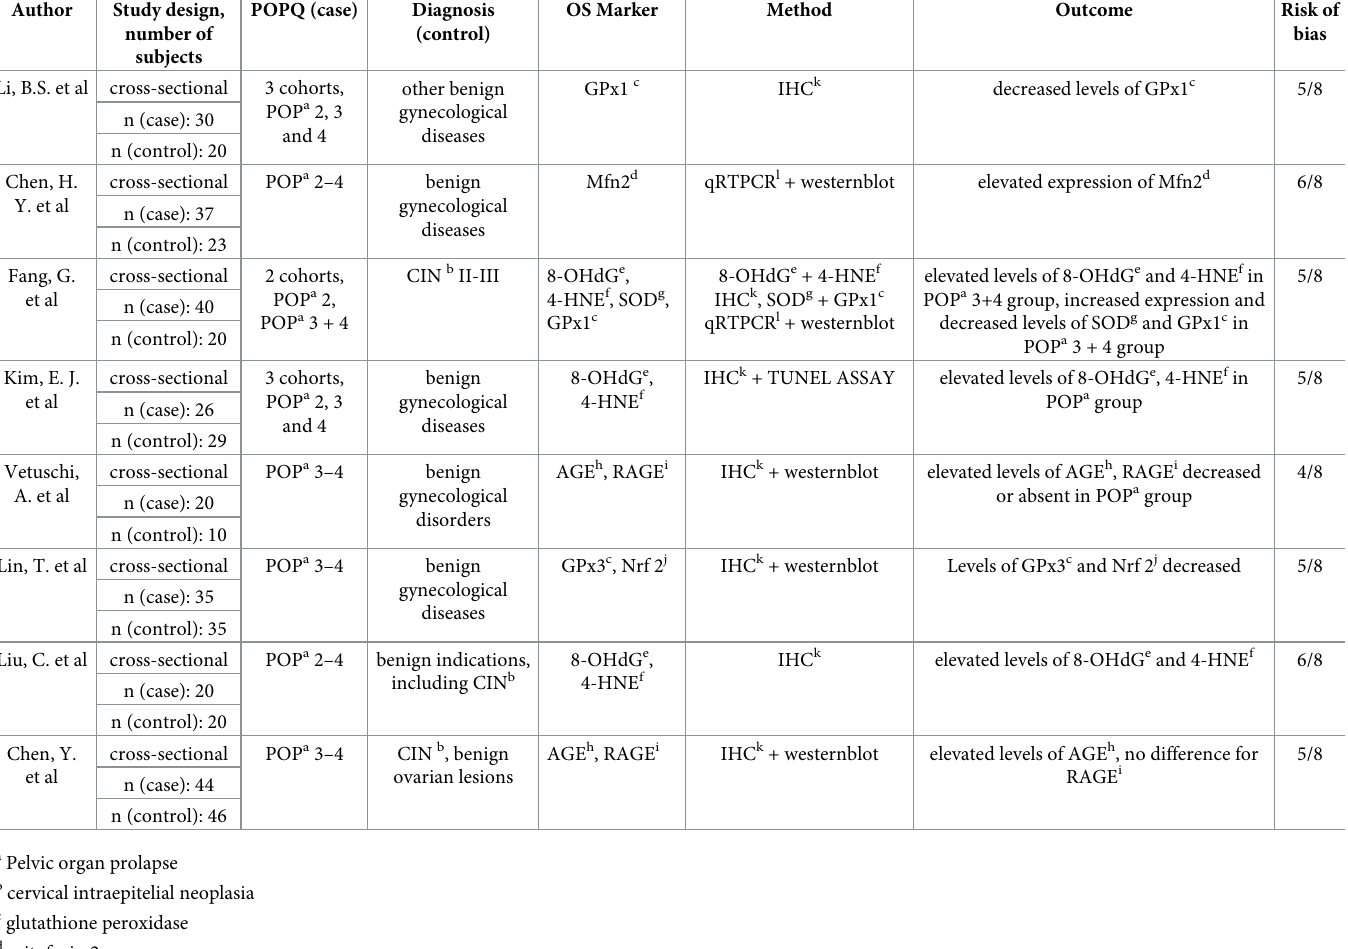
Table 1. Selected data of markers of oxidative stress in patients with